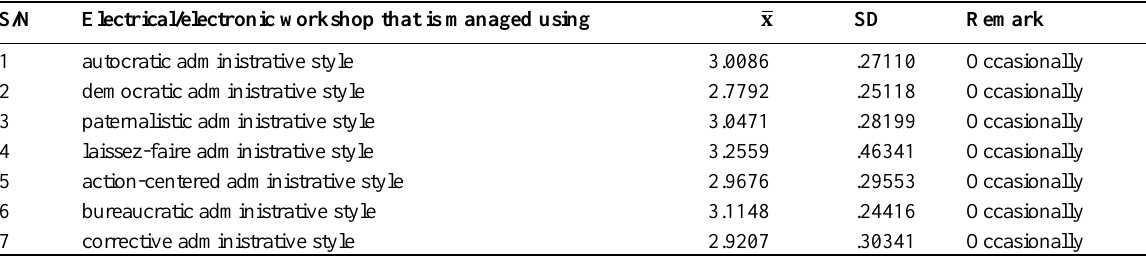
Table 1 : Mean Score of Accident Rates in Different Electrical/Electronic workshops Managed using Different Administrative